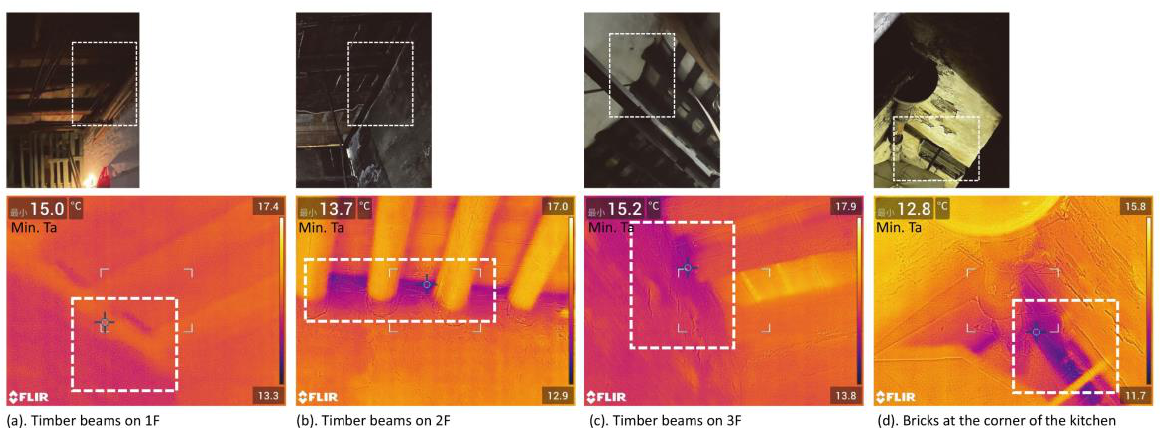
Figure 12. Thermal images of the construction and materials (photo by the students).